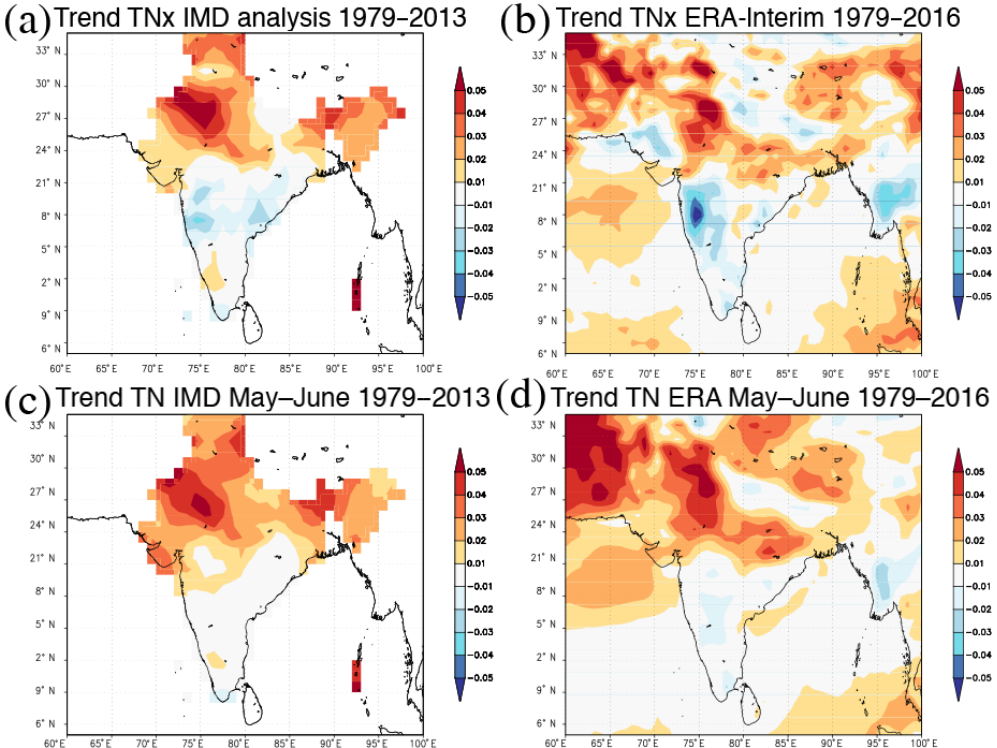
Figure 9. (a) Trend in the highest minimum temperature in May in the IMD analysis (Srivastava et al., 2008) for 1979–2015 (Kyr − 1 ), (b) same as in the ERA-Interim reanalysis for 1979–2016; (c, d) same as (a, b) but for the trend in the May mean minimum